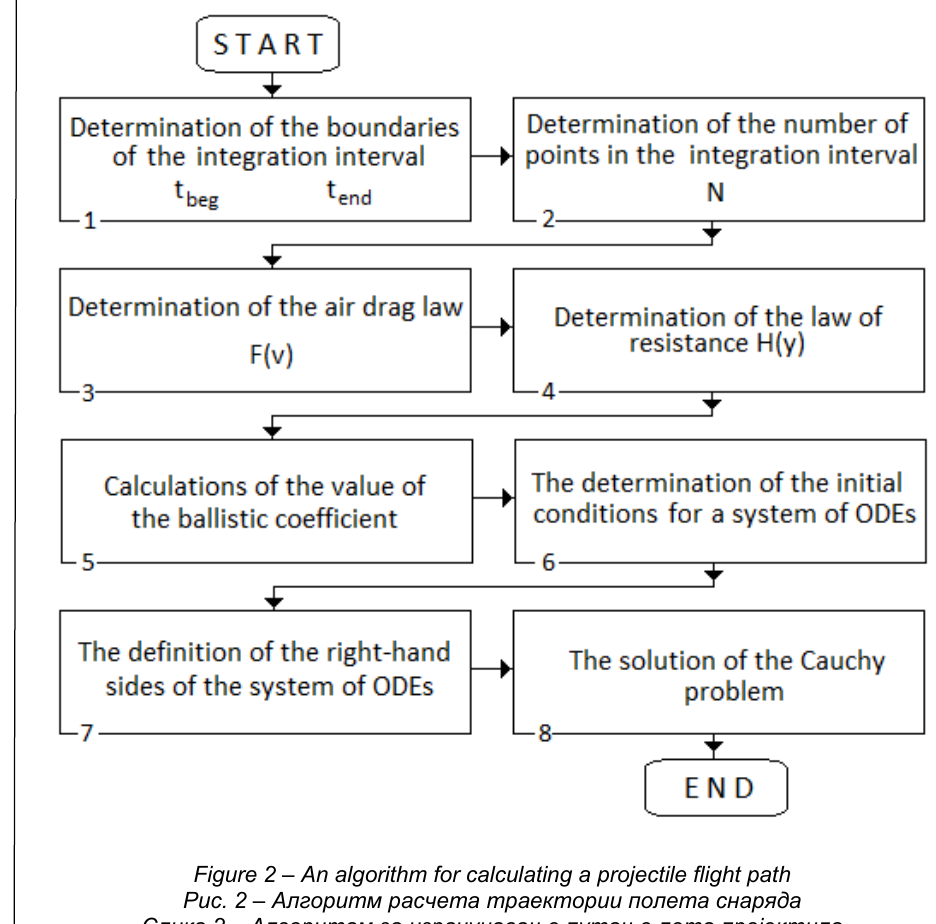
Figure 2 – An algorithm for calculating a projectile flight path Рис . 2 – Алгоритм расчета траектории полета снаряда Слика 2 – Алгоритам за израчунавање путање лета пројектила MM&CS Stage 3. Program-code for a numerical